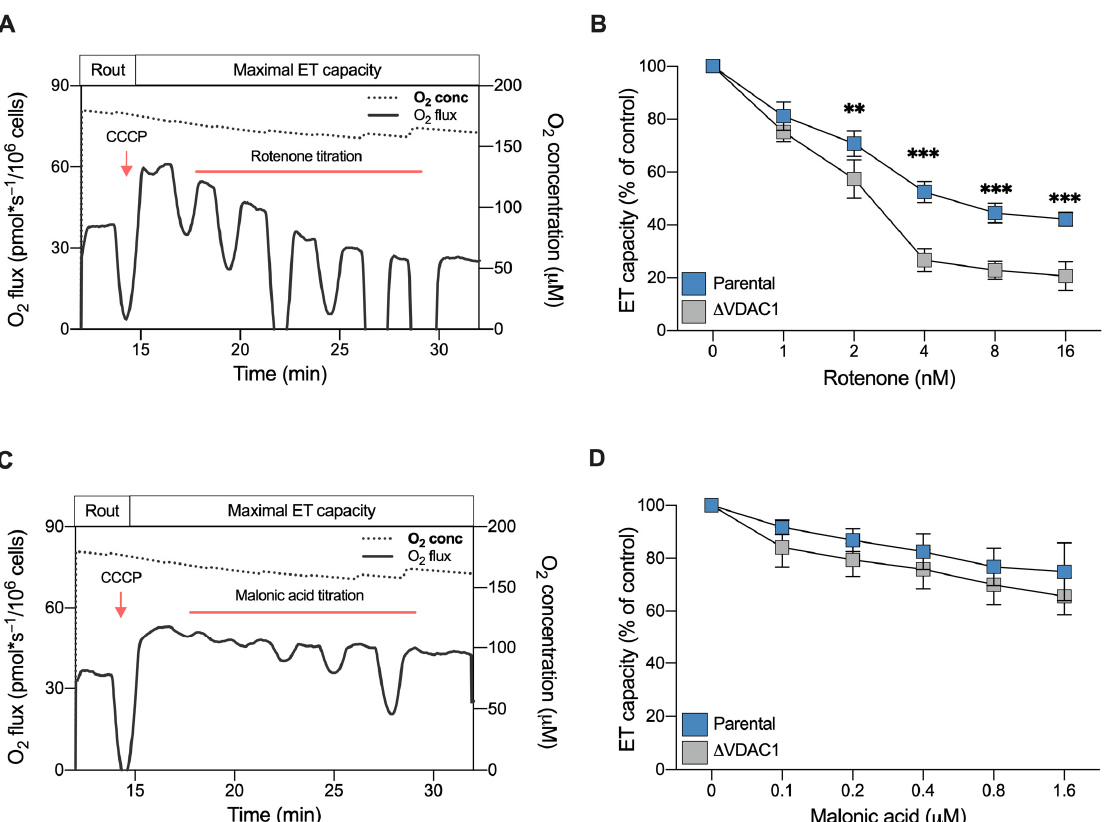
Figure 7. Sensitivity of HAP1 cells to complex I and II inhibitors assayed by HRR. ( A ) A representative curve of mitochondrial respiratory profile of parental HAP1 intact cells, in addition to the SUIT protocol used here. After achieving the of ET capacity with CCCP, respiration was monitored upon rotenone titration (1–16 nM). ( B ) Quantitative analysis of ET capacity upon rotenone titration showing a reduction for both parental and ∆ VDAC1 cells. However, an increased sensitivity to rotenone was observed for ∆ VDAC1 cells in comparison to the parental cells. ( C ) A representative curve of the mitochondrial respiratory profile of parental HAP1 intact cells, in addition to the SUIT protocol used here for malonic acid titration (0.1–1.6 µ M). ( D ) Quantitative analysis showing reduction of ET capacity upon titration with malonic acid. No significant difference in the respirometric profile was observed for parental and ∆ VDAC1 cells. Data in ( B , D ) are shown as means ± SEM of n = 3 independent experiments and statistically analyzed by a two-way ANOVA, with ** p < 0.01 and *** p < 0.01.